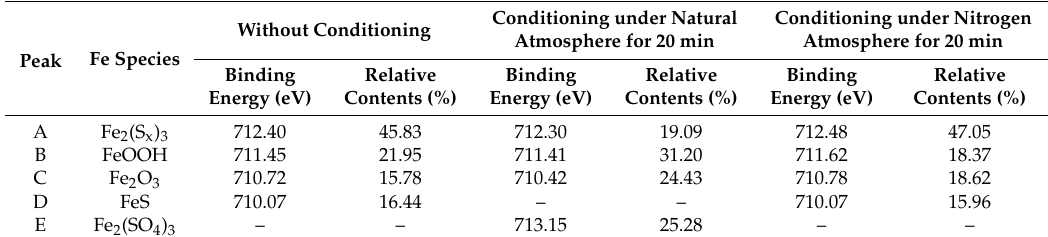
Table 2. Fe species binding energy (eV) and relative contents (%) for the pyrrhotite surface treated with different types of conditioning.